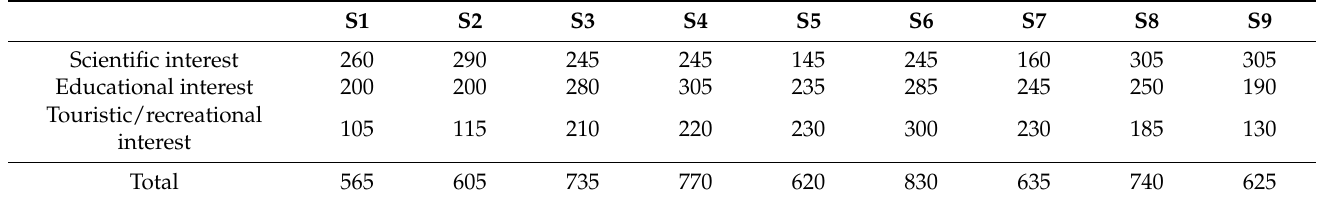
Table 2. Weighted values of the geosites according to their scientific, educational and touristic values.